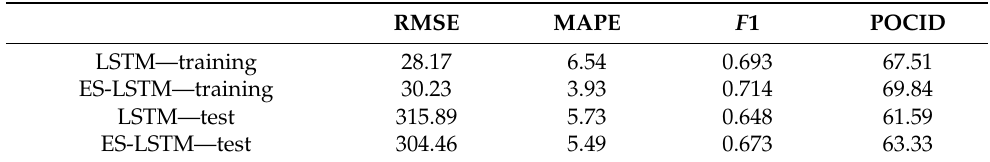
Table 2. ETH–USD: accuracy comparison, delay = 1.